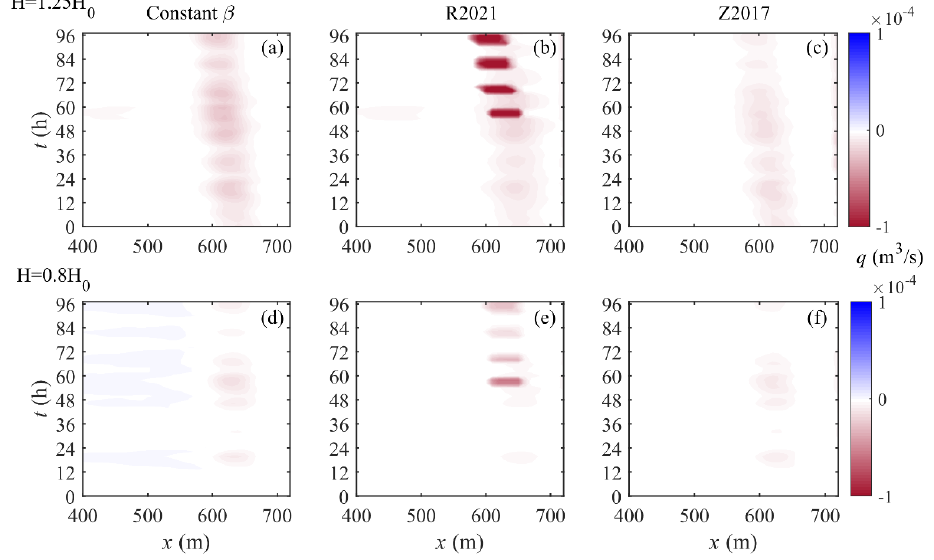
Figure 7. Spatial–temporal evolution of the suspended sediment transport rate predicted by constant roller slope ( a , d ) and the roller slope of R2021 ( b , e ) and Z2017 ( c , f ) under two different wave heights. Figure 7a–c are calculated with H = 1.25 H 0 , and Figure 7d–f are calculated with H = 0.8 H 0